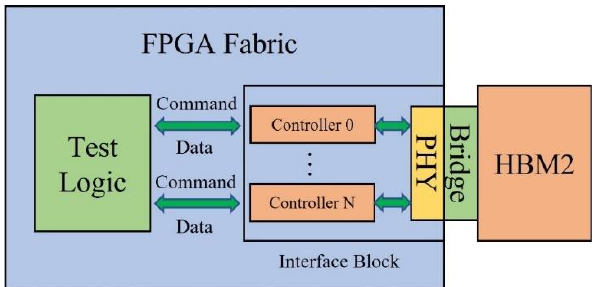
Figure 1. FPGA and two HBM2 dies integrated as a single package (only one HBM2 is shown; the HBM2 controller is embedded inside the FPGA and connected to HBM2).